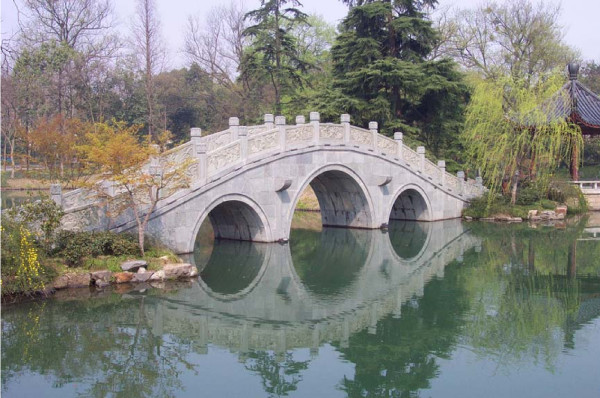
West Lake, Hangzhou.